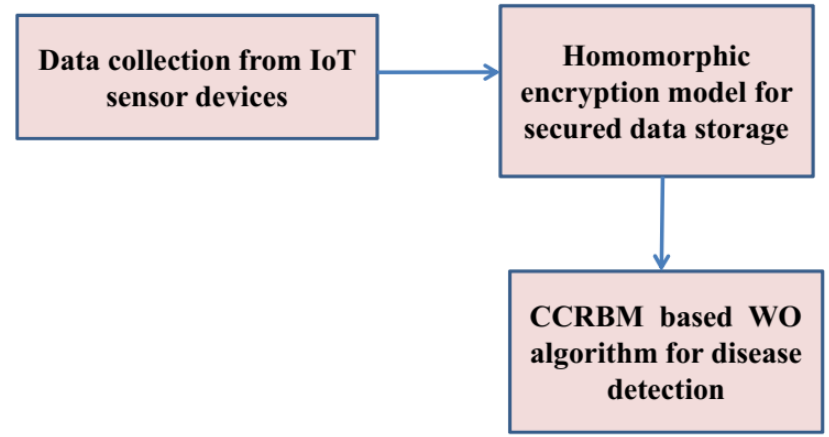
Figure 1. Proposed workflow diagram.